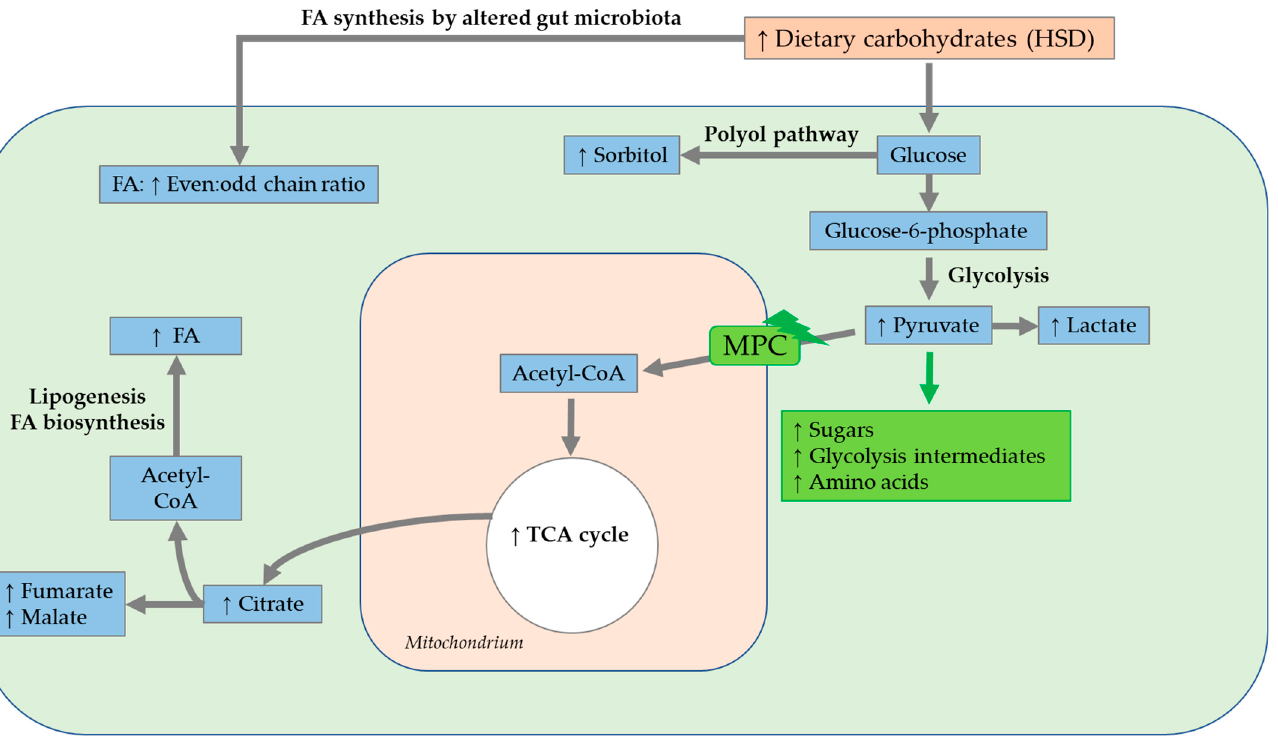
Figure 14. Metabolomic changes in Drosophila melanogaster in response to high-sugar diet (HSD) feeding. Flies fed an HSD supplemented with sucrose show elevated levels of pyruvate and lactate, which can be explained by stimulation of the glycolysis pathway. Moreover, the levels of fatty acids (FA) and stored lipids are increased, indicative of enhanced lipogenesis and FA biosynthesis [130,169]. Additionally, flies fed an HSD exhibit fewer odd-chain esterified FAs in all examined tissues, which is most likely attributable to an altered composition of the gut microbiota [169]. In- gestion of an HSD leads to increased levels of sorbitol produced via glucose utilization in the polyol pathway [130]. Effects elicited by long-term feeding on an HSD are depicted with green symbols and boxes. Long-term HSD exposure negatively affects the mitochondrial pyruvate carrier (MPC) in the inner mitochondrial membrane (lightning bolt). Mild MPC deficiency is associated with increased accumulation of sugars, glycolysis intermediates and amino acids (green box), and a reduction in pyruvate-stimulating respiration suggests metabolic inflexibility and the disruption of homeosta- sis [166] (modified from [130,166,169]). Acetyl-CoA, acetyl-coenzyme A; TCA, tricarboxylic acid; ↑ increase; ↓ decrease; thickness of arrows indicates flux